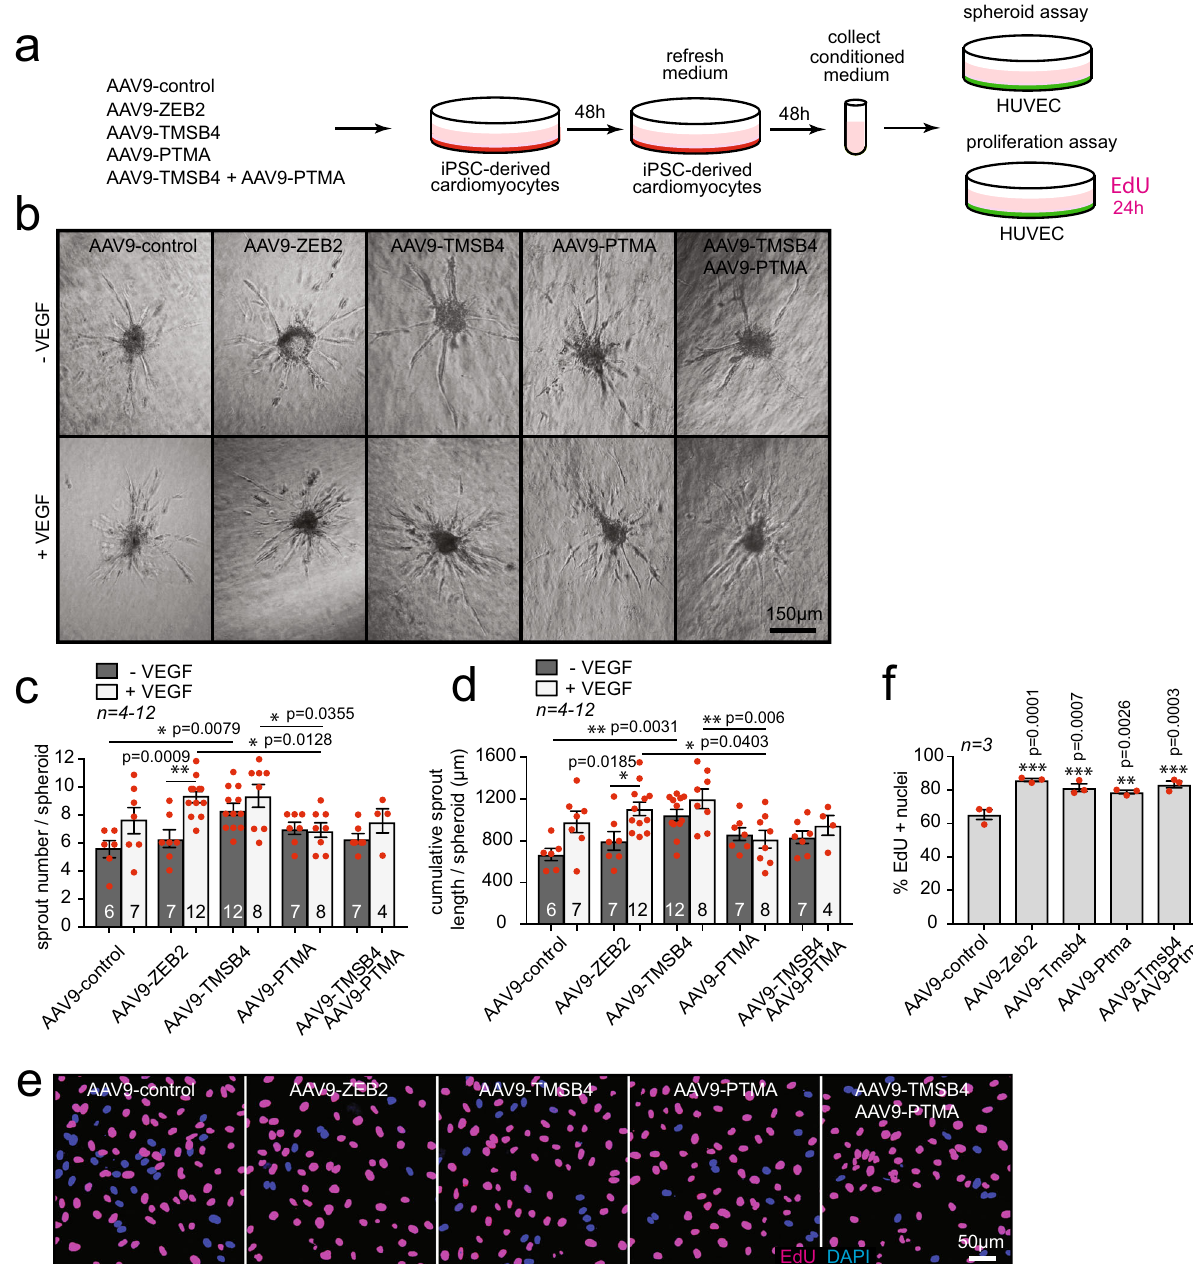
Fig. 6 Overexpression of ZEB2, TMSB4, and PTMA in cardiomyocytes enhances endothelial cell migration and proliferation. a Experimental setup. b Representative images of sprouts formed by HUVECs upon treatment indicated in ( a ). c Quanti fi cation of sprouts number per spheroid. d Quanti fi cation of cumulative sprout length per spheroid. Data in b - d is from one experiment with 4-12 biological replicates. e Representative immuno fl uorescent images of HUVECs treated as indicated in ( a ), nuclei stained for DAPI and EdU. f Quanti fi cation of EdU positive nuclei. Data are represented as mean ± SEM, * p < 0.05, ** p < 0.01, *** p < 0.001, each dot indicates a biological replicate, n is indicated in fi gures. Data were analyzed by ordinary one-way ANOVA with Dunnett ’ s multiple comparison test ( f ) and with two-way ANOVA with Sidak ’ s multiple comparison test ( c , d ). Source data are provided as a Source Data fi